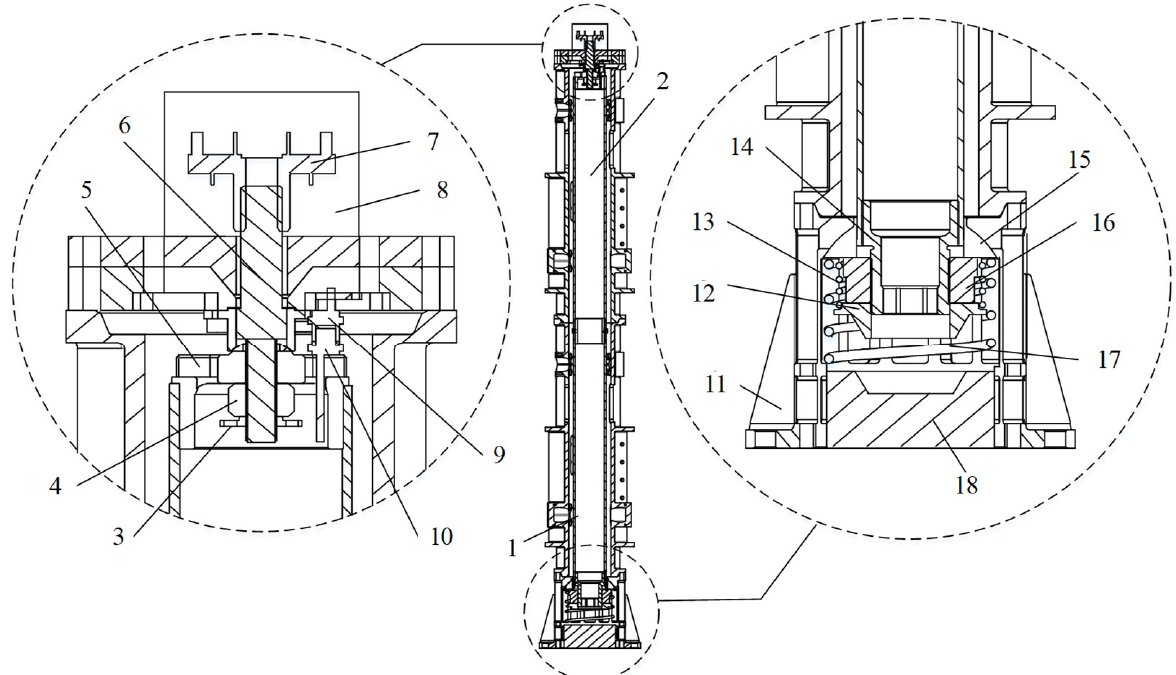
Figure 3. Structure of compression mechanism: 1—loader post; 2—guide bar; 3—locknut;